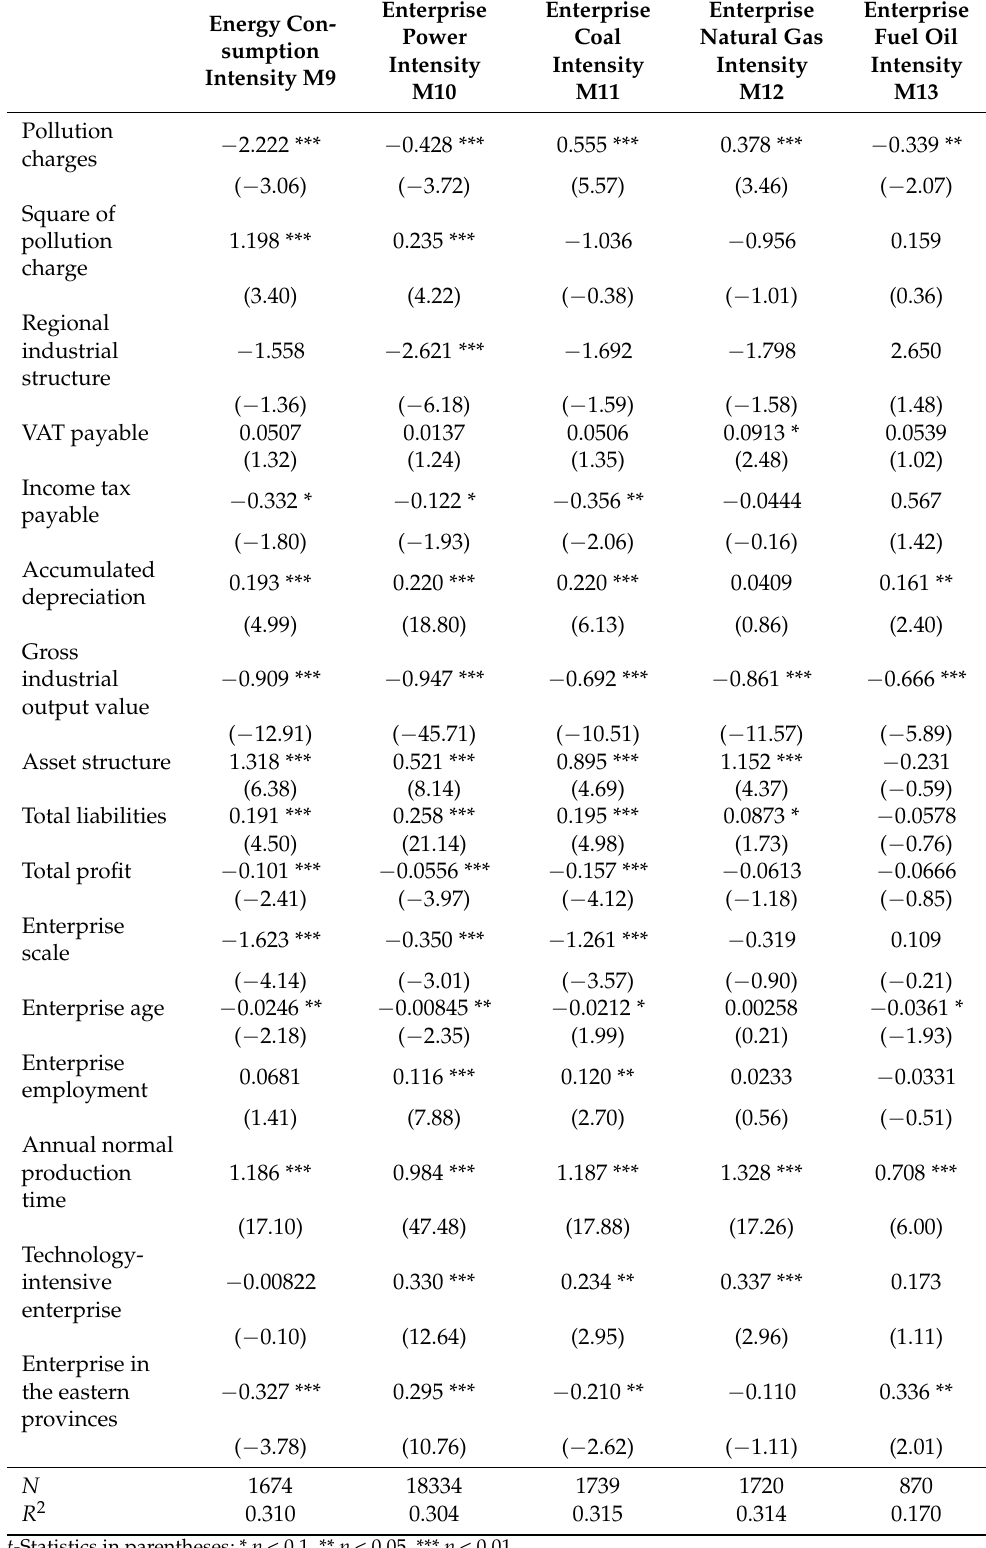
Table 5. Regression results of the impact of pollution charges on enterprises’ energy-saving techno- logical innovation in